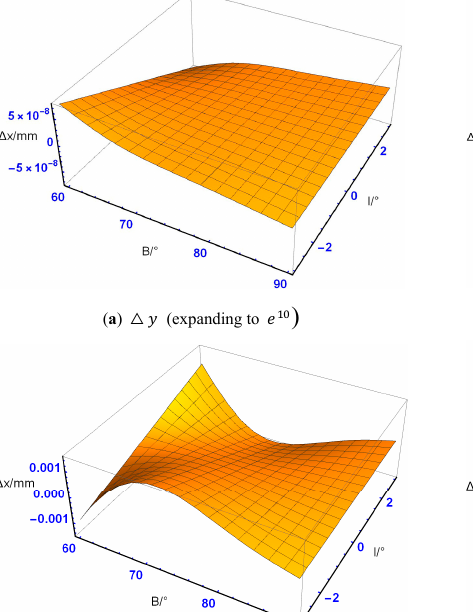
Figure 4. The distribution of the abscissa truncation difference △ 𝑥 when expanding to 𝑒 (cid:2869)(cid:2868) , 𝑒 (cid:2876) , 𝑒 (cid:2874) , and 𝑒 (cid:2872) .